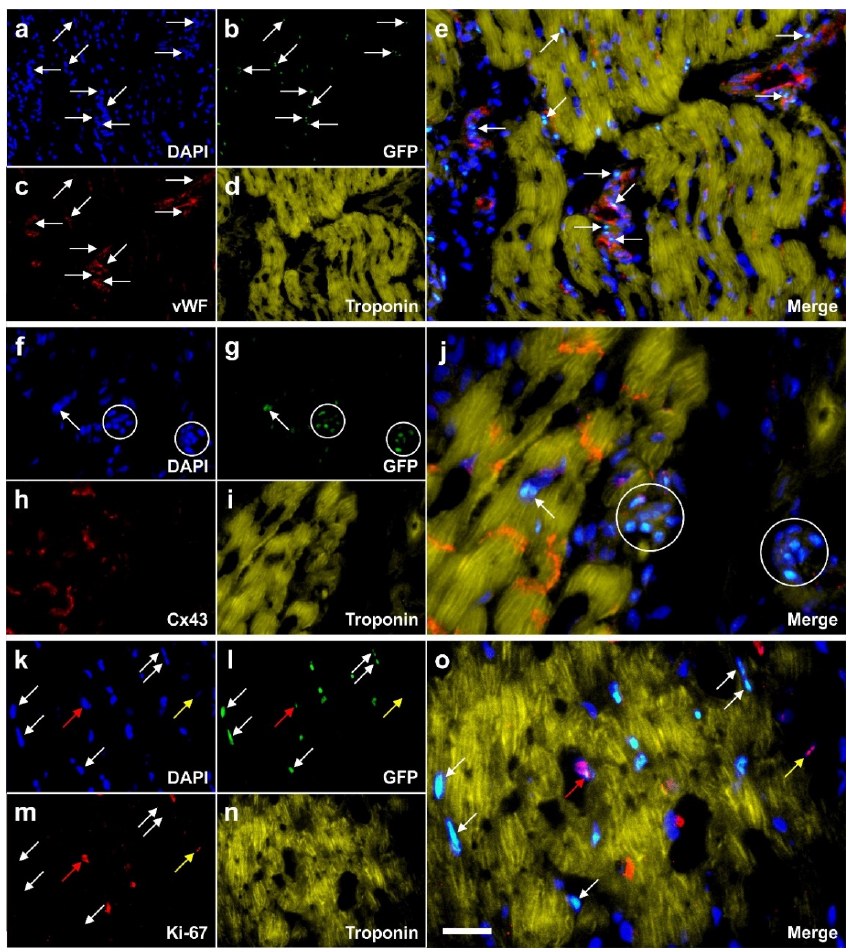
Figure 6. Representative, previously unpublished example how autologous, adipose derived stem cells can stay locally, survive and engraft in the new host tissue into which the cells were applied, differentiate under guidance of the new microenvironment, integrate into the new host tissue and participate in building new vascular structures in the host tissue. The panels show photomicrographs of paraffin-embedded, 5 µm thick tissue sections of a post mortem heart from a pig, taken from the left ventricular border zone of myocardial infarction ten weeks after experimental occlusion of the left anterior descending (LAD) artery for three hours, followed by delivery of eGFP-labeled autologous ASCs into the balloon-blocked LAD vein (matching the initial LAD occlusion site) at four weeks after occlusion of the LAD (experiments are described in detail in [111]). ( a – e ) One tissue section was stained with DAPI (blue) ( a ) and processed for immunofluorescent detection of GFP (green) ( b ), von Willebrand factor (vWF) (red) ( c ) and Troponin (yellow) ( d ). The arrows indicate cell nuclei that were immunopositive for GFP and were found in the wall of small vessels (the positions of these cell nuclei are also labeled in the panel representing vWF). ( f – j ) Another tissue section was was stained with DAPI (blue) ( f ) and processed for immunofluorescent detection of GFP (green) ( g ), Cx43 (red) ( h ) and Troponin (yellow) ( i ). The circles indicate regions where most of the cell nuclei were immunopositive for GFP, and the arrow a GFP-positive cell nucleus inside (or directly adjacent to) a cardiomyocyte. (k– o ). A third tissue section was stained with DAPI (blue) ( k ) and processed for immunofluorescent detection of GFP (green) (l), Ki-67 (red) ( m ) and Troponin (yellow) ( n ). The white arrows point to cell nuclei that were immunopositive for GFP but not for Ki-67, the yellow arrows to a cell nucleus that was immunopositive for Ki-67 but not for GFP, and the red arrows to a cell nucleus that was immunopositive for both GFP and Ki-67 (indicating that this cell had re-entered the cell cycle). The scale bar represents 25 µm in the merged panels and 50 µm in the individual panels.